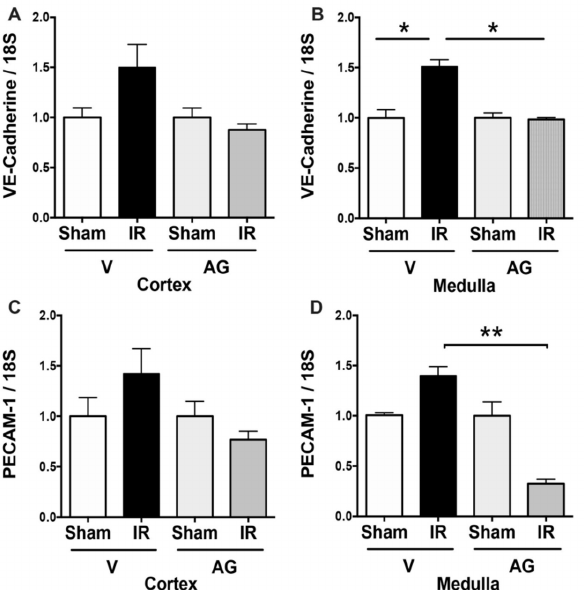
Figure 7. AG prevented VE-cadherin and PECAM upregulation induced by IR. BALB/c mice were treated with either vehicle or AG (50 mg/kg i.p) before sham or subjected to 30 min of ischemia and 48 h of reperfusion. VE-cadherin and PECAM-1 expressions were determined by qPCR in sham (n = 5), IR (n = 5), AG-sham (n = 6), and AG-IR (n = 6). ( A ) VE-cadherin mRNA in the cortex. ( B ) VE-cadherin mRNA in the medulla. ( C ) PECAM-1 mRNA in the cortex. ( D ) PECAM-1 mRNA in the medulla. The bar graph represents mean ± SEM using ANOVA non-parametric Kruskal–Wallis test. * p < 0.05, ** p <